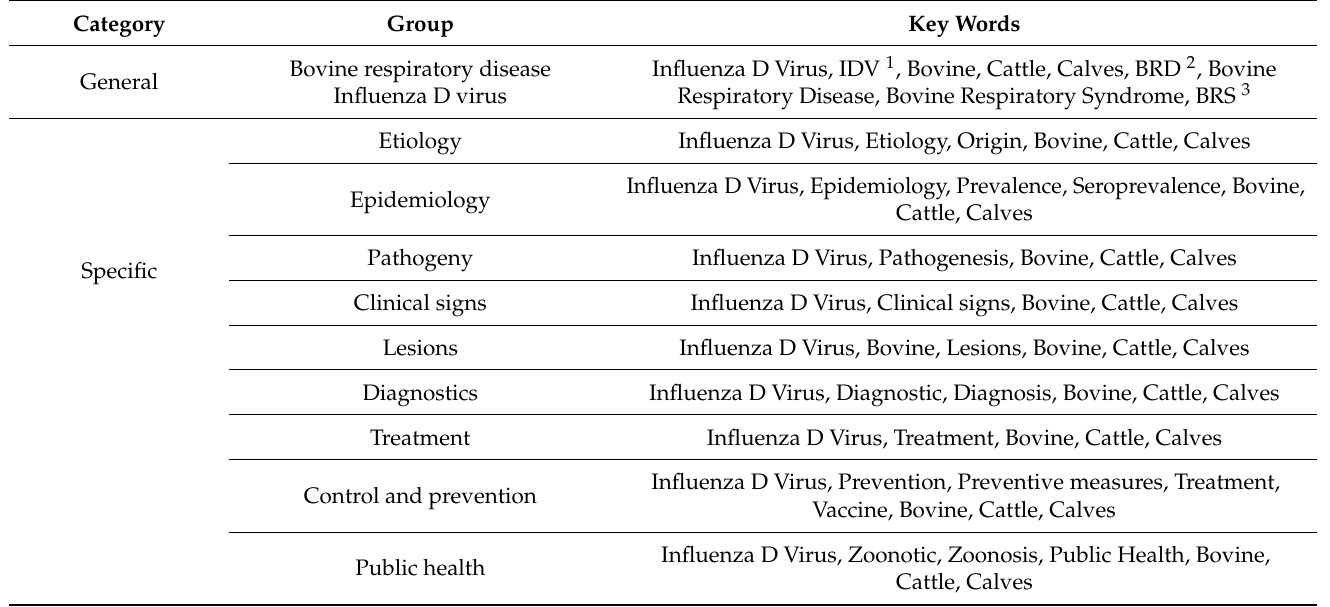
Table 1. Detail of the data search and key words used in Google Scholar, PubMed, Scopus and Web of Science (accessed from November 2021 to October 2022). For important topics, full words and their most commonly used abbreviations in the scientific literature were used with the Boolean operators AND, OR, and